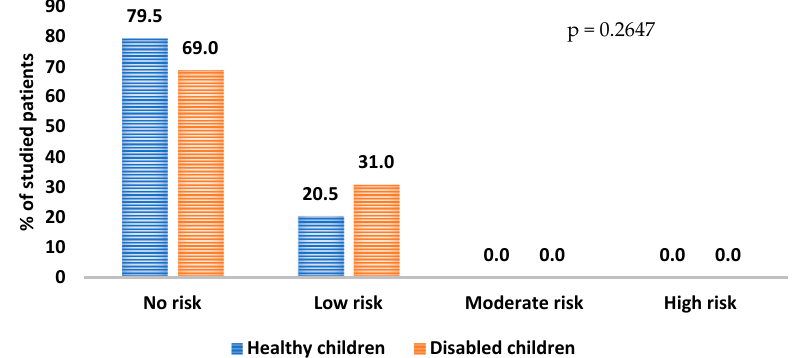
Figure 1. Interpretation of the severity of erosive tooth wear in selected groups of children.